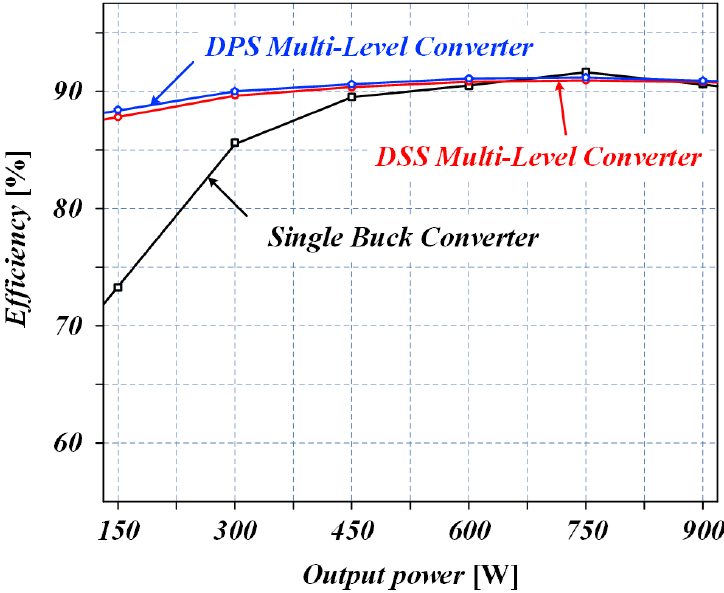
Figure 18. Comparison between the efficiency curves of three topologies.